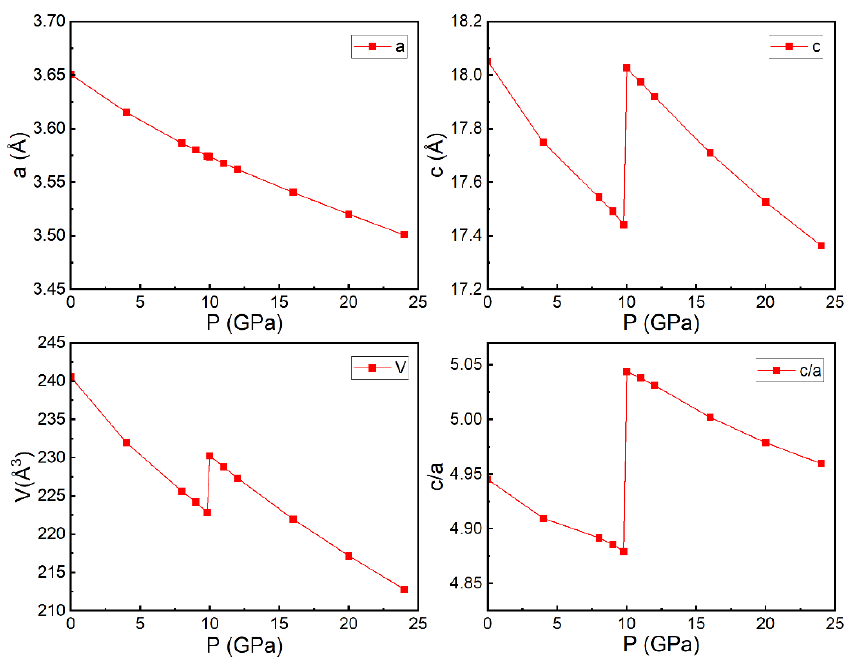
Figure 4. Variations of the unit cell parameters a, c, cell volume (V) and c/a as a function of pressure.